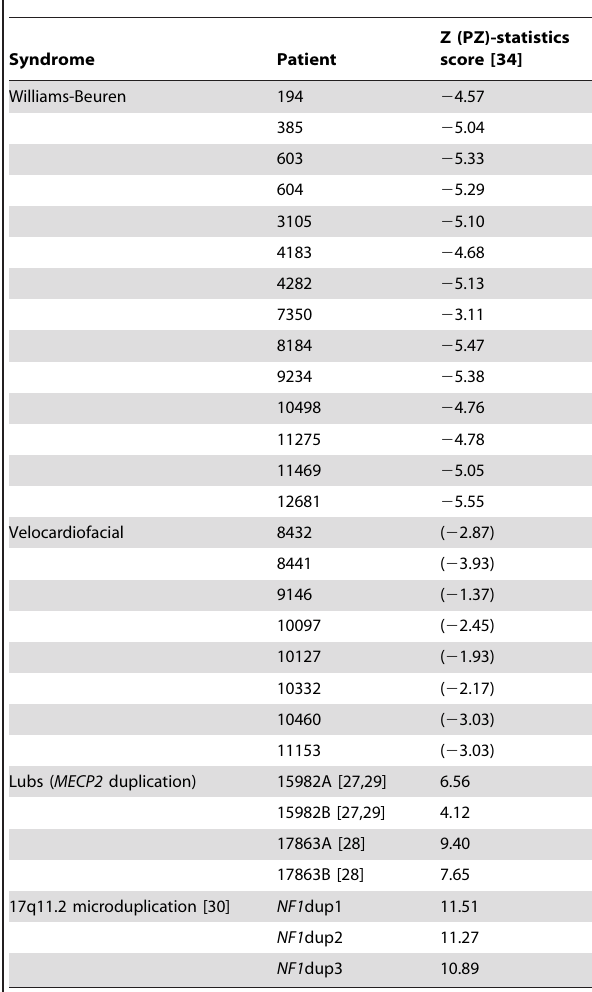
Table 1. MQF-PCR results for patients with microdeletion and microduplication